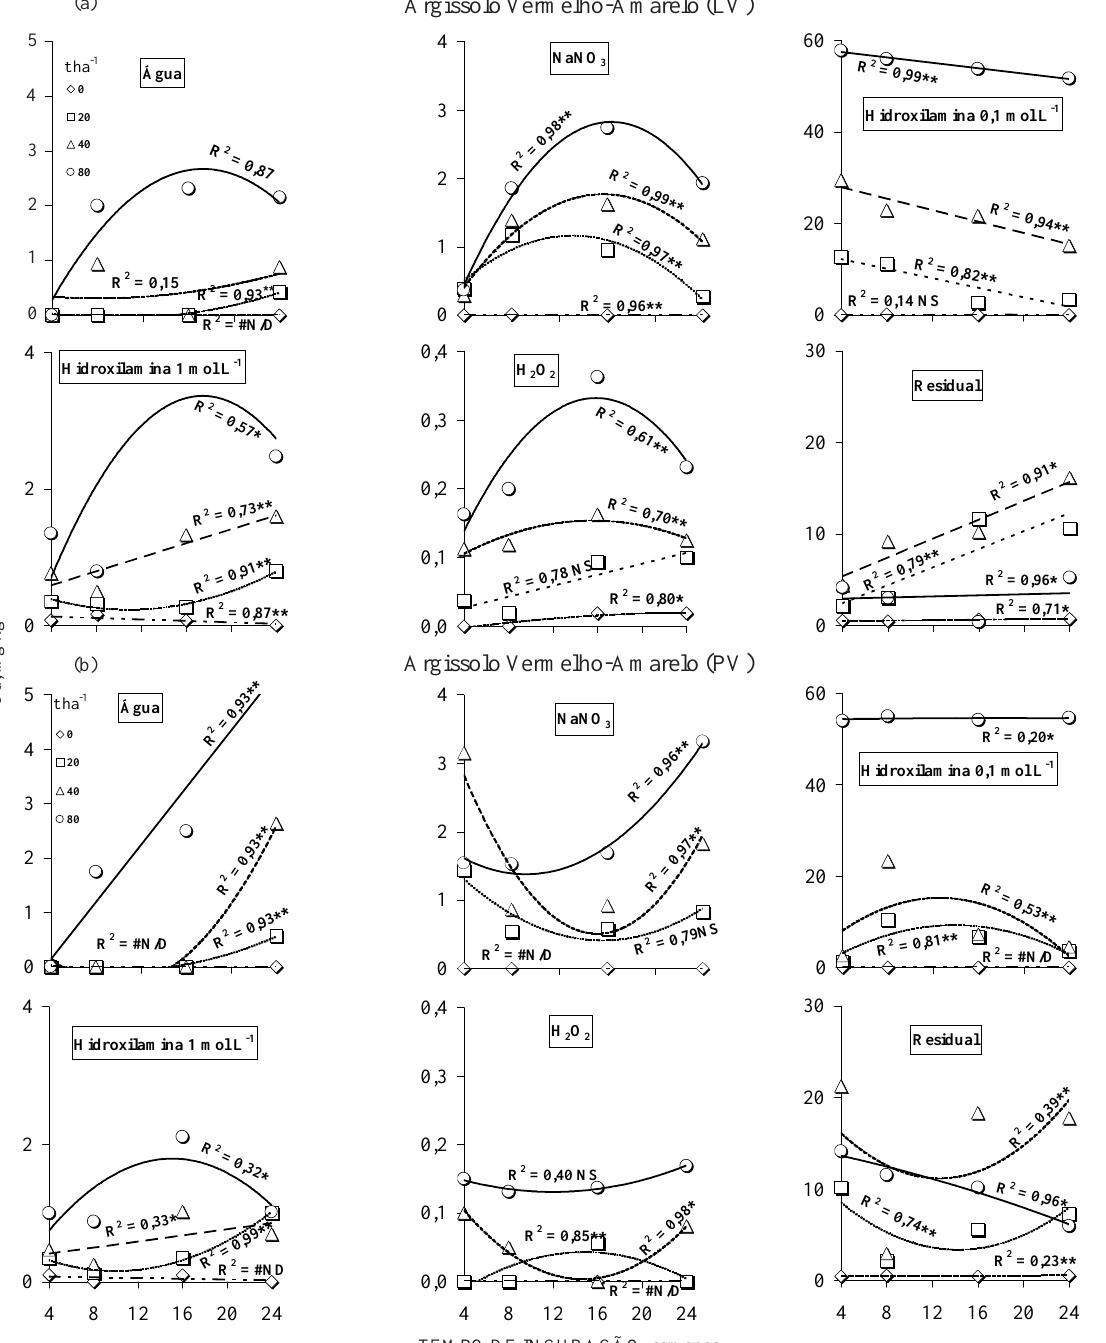
Figura 2. Efeito de tempo de incubação e dose de lodo de esgoto na extração seqüencial de Cd nos solos LV (a) e